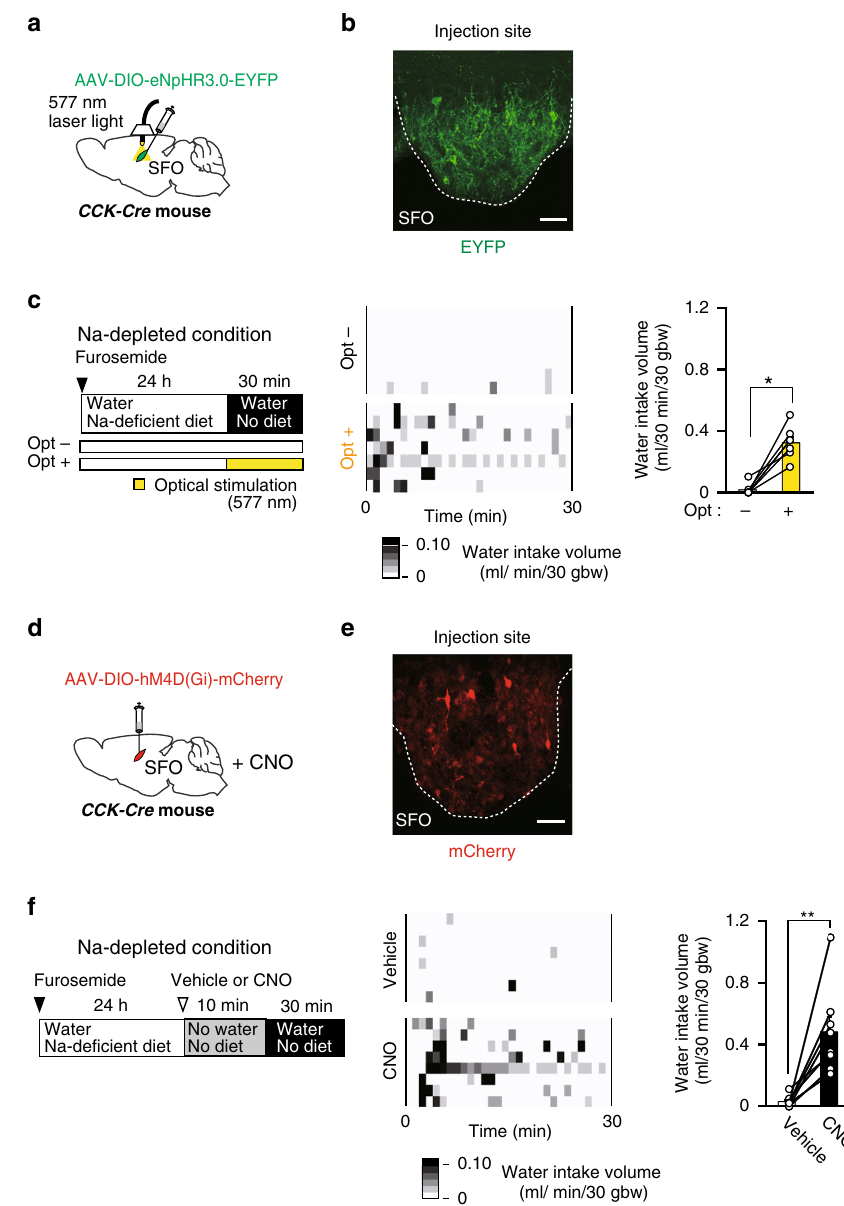
Fig. 4 Optical or chemogenetic silencing of CCK-positive neurons in the SFO induces water intake under the Na-depleted condition. a Injection of AAV- DIO-eNpHR3.0-EYFP into the SFO of the CCK-Cre mouse. b Immunohistochemical staining of EYFP in the SFO. Scale bar, 50 µ m. c Left: Experimental protocol to stimulate water intake under the Na-depleted condition with (opt + ) or without (opt – ) optical inactivation (wavelength, 577 nm). Center: Grayscale heat maps of water intake by individual mice with or without the optical stimulation. Right: Summary of water intake under the Na-depleted condition with or without the optical silencing of CCK-positive neurons in the SFO ( n = 7 mice each; W = 0, P = 0.016). d Injection of AAV-DIO-hM4D (Gi)-mCherry into the SFO of the CCK-Cre mouse. e Immunohistochemical staining of mCherry in the SFO. Scale bar, 50 µ m. f Left: Experimental protocol to stimulate water intake under the Na-depleted condition by a subcutaneous injection of the vehicle or CNO (2 mg/kg). Center: Grayscale heat maps of water intake by individual mice treated with the vehicle or CNO. Right: Summary of water intakes with the vehicle or CNO injection under the Na-depleted condition ( n = 8 mice each; W = 0, P = 0.008). Immunohistochemical images in ( b ) and ( e ) were reproduced from more than three independent mice. bw, body weight. ** P < 0.01; * P < 0.05; two-sided Wilcoxon ’ s signed-rank tests in ( c ) and ( f ). Data represent the mean ±